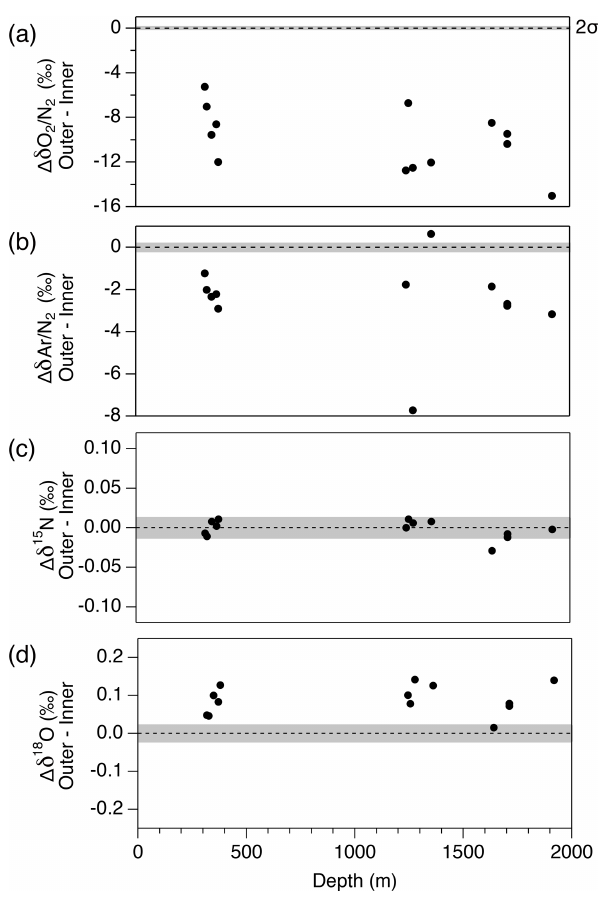
Figure 13. Pair difference ( (cid:49) ) between outer ice and inner ice for (a) δ O 2 / N 2 , (b) δ Ar / N 2 , (c) δ 15 N and (d) δ 18 O. Grey shadings indicate the estimated 2 σ uncertainty for clathrate ice (from pooled SDs of duplicates with > 8mm of outer removal).